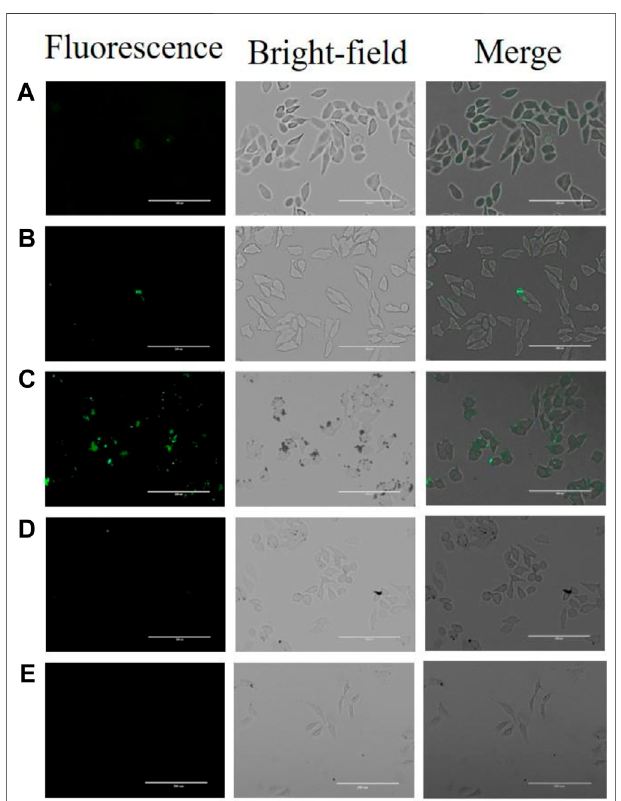
FIGURE 9 | Confocal microscopy images of A549 cells or HuH-7 cells following treatment of (A) QDs, (B) QD-aptamers, (C) aptamer sensors, and (D) pretreated cells with CD133-targeted aptamers for 24 h and then incubatedwiththeaptamersensor. (E) HuH-7cellsweretreatedwiththe aptamer